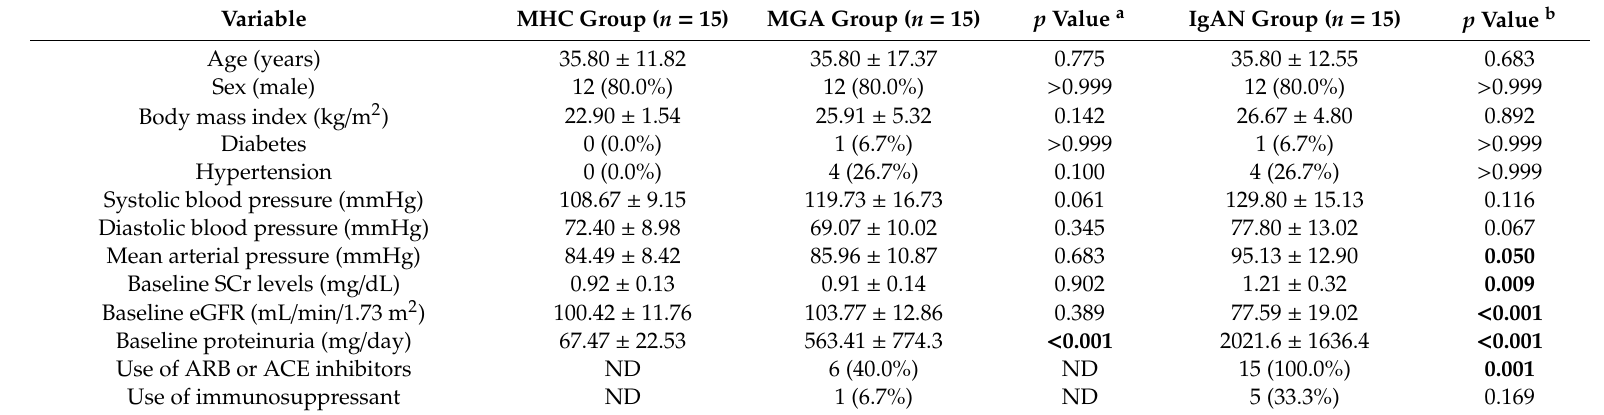
Table 3. Baseline characteristics of the MGA, MHC, and IgAN groups in the prospective